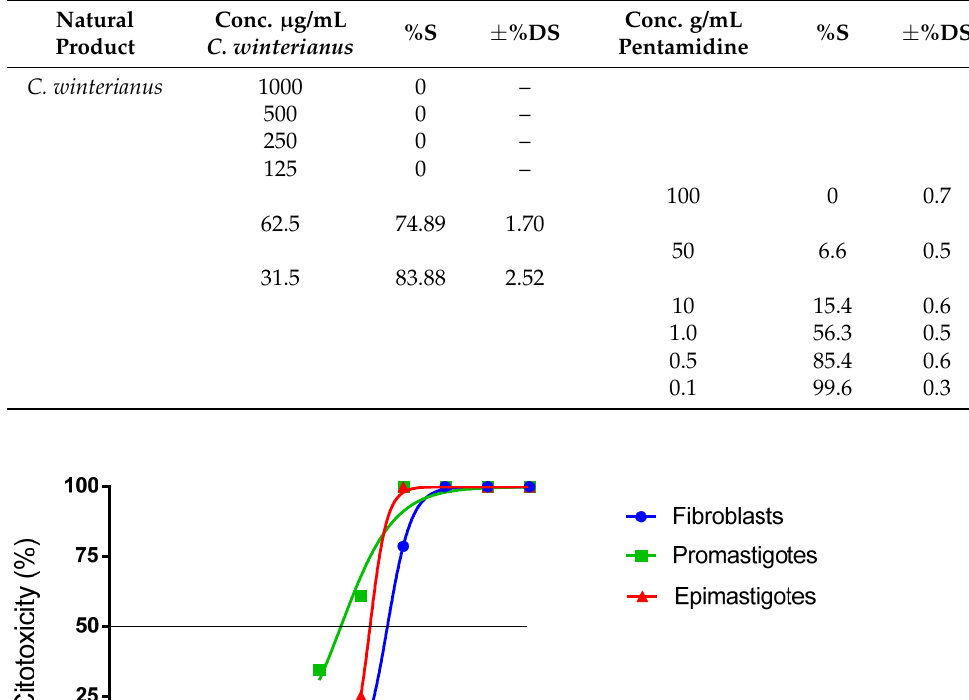
Table 4. Survival of the epimastigote T. cruzi treated with the essential oil of C. winterianus .